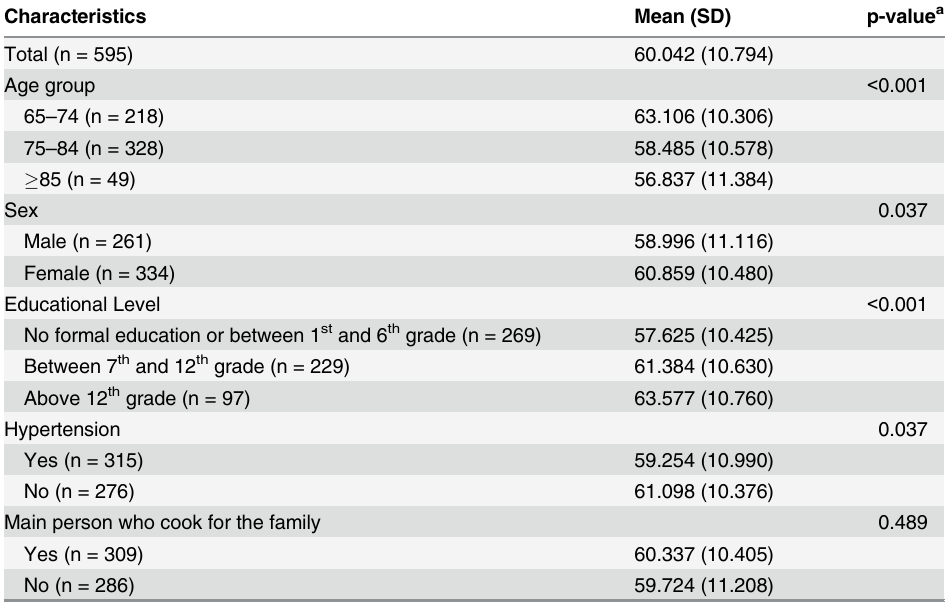
Table 3. Mean and standard deviation (SD) CHLSalt-HK score and its relationships with demographic variables.